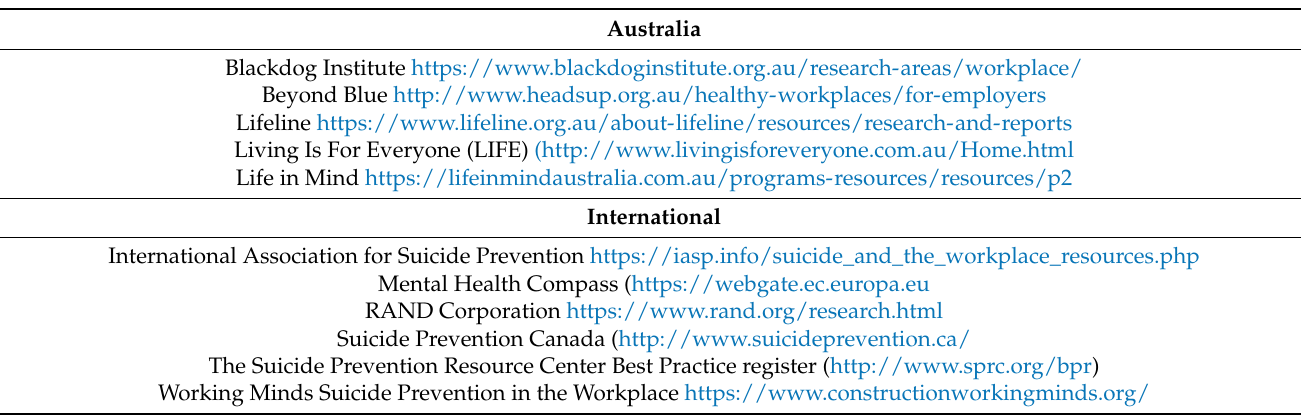
Table A2. List of peak organisations included in the identification of eligible studies (accessed on 14 June